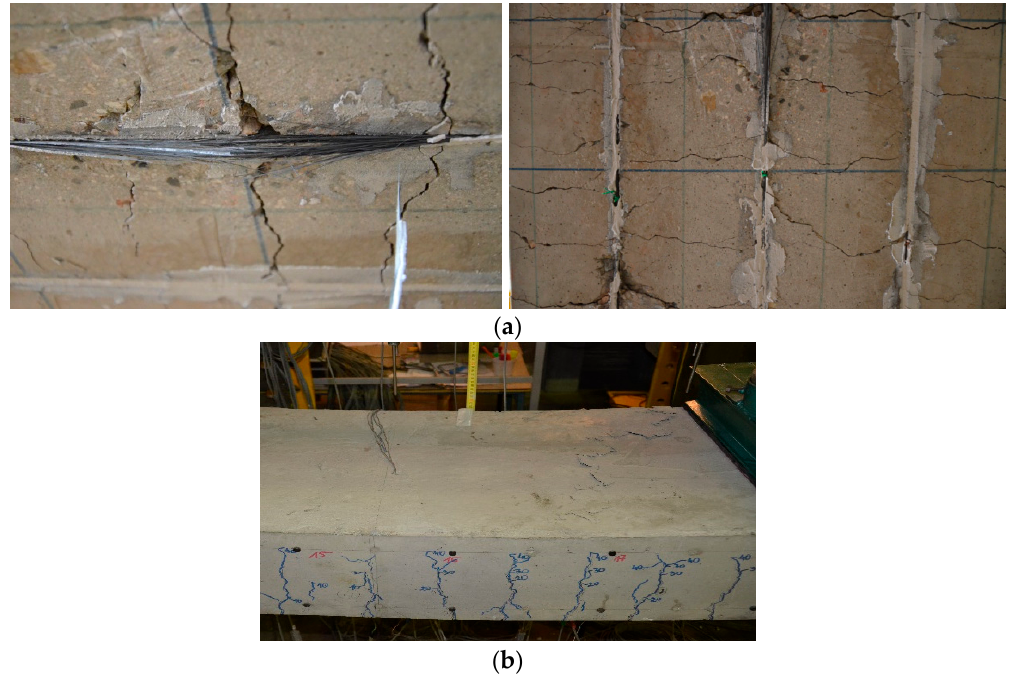
Figure 6. Failure of the specimens in series A: ( a ) bottom view of NSM12A with rupture of CFRP strips; and ( b ) the top view of NSM16A with concrete crushing.